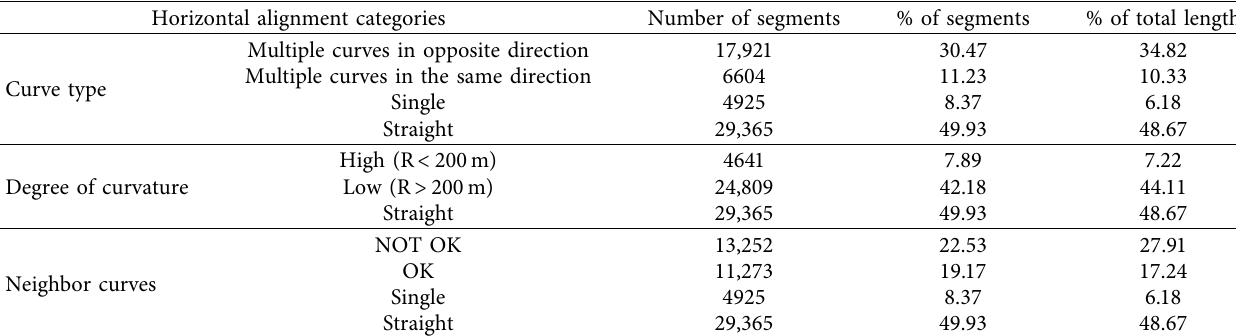
Table 2: Descriptive statistics on horizontal